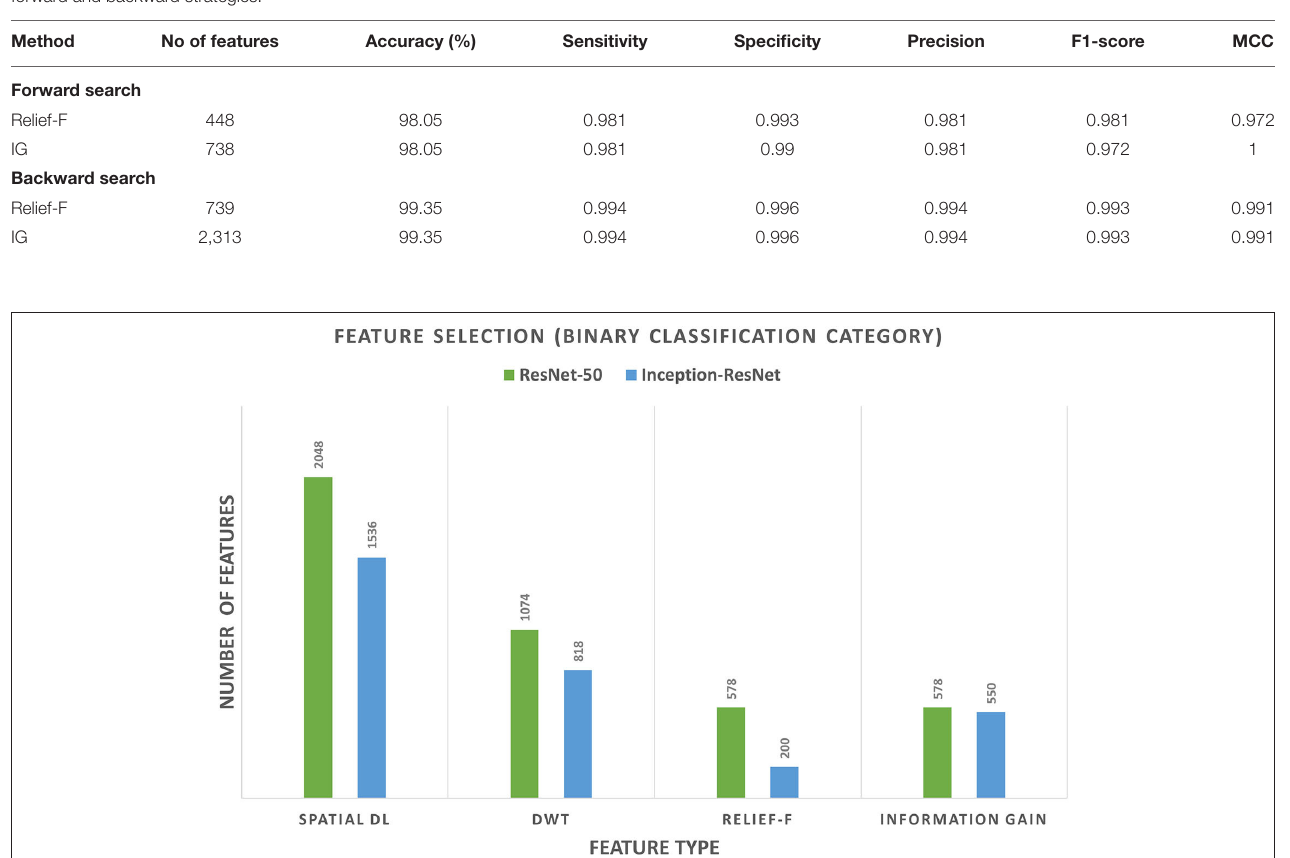
FIGURE 6 | The number of features of Scheme I (spatial DL feature extraction), feature reduction (DWT), and the Relief-F and information gain feature selection methods for both Inception-ResNet-V2 and ResNet-50 CNNs for the binary classification